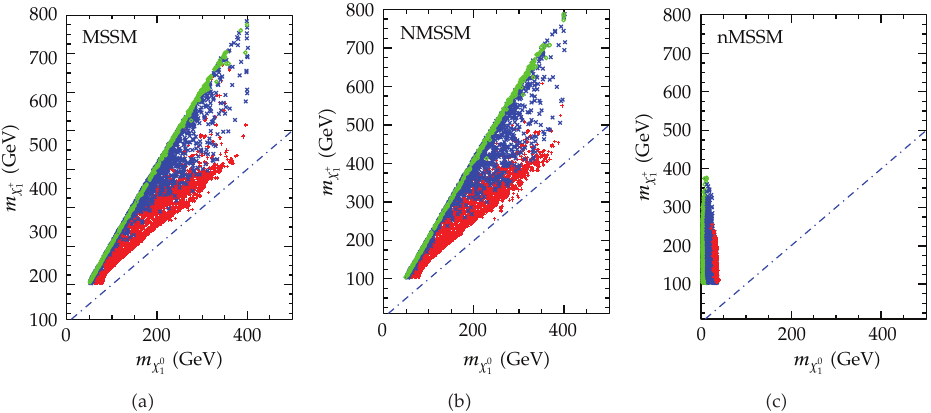
Figure 3: Same as Figure 1, but showing the chargino mass m χ (cid:8) (cid:7) m (cid:2) taken for (cid:5) 46 (cid:6)(cid:3) cate m χ (cid:8) χ 0 1 1